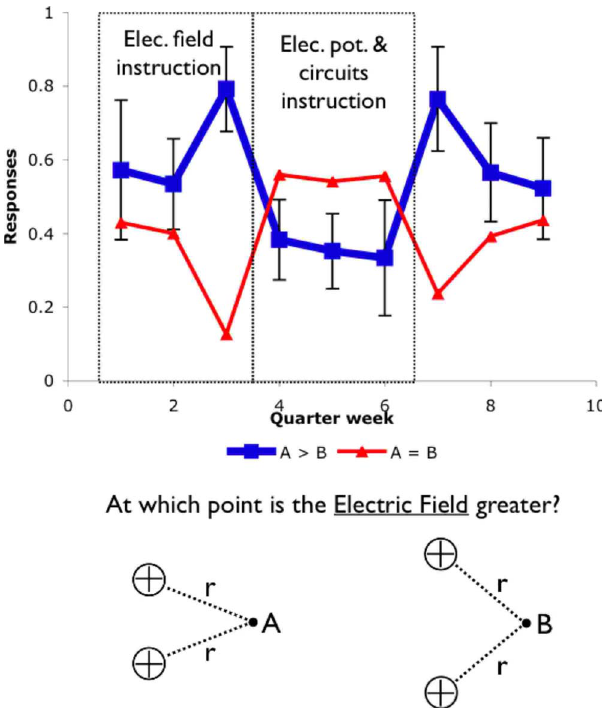
FIG. 4. (cid:1) Color online (cid:2) Prompt and responses to a question com- paring the electric fields near two pairs of positive charges. The correct answer (cid:1) blue and bold (cid:2) decreases dramatically when poten- tial is taught, then recovers. The third response, that B (cid:2) A , was chosen in (cid:3) 7 % of all responses.